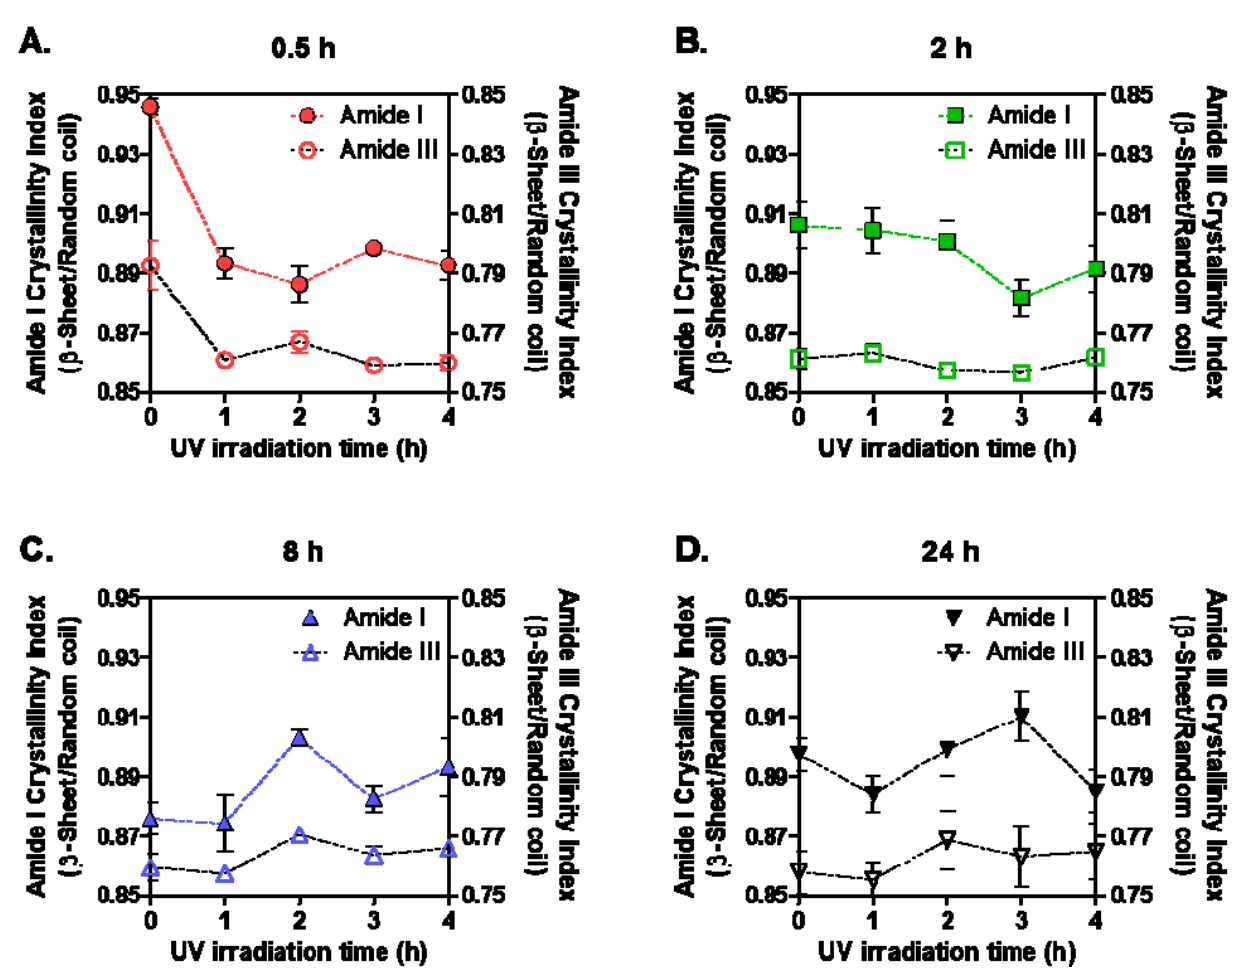
Figure 6. Amide I and III crystallinity index calculated from FT-IR spectra of UV-irradiated SF films prepared with four SF solutions that were dissolved for different times ( A : 0.5 h; B : 2 h; C : 8 h; D : 24 h) (n > 6; mean ± SEM).